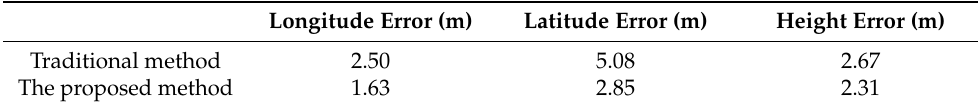
Table 1. Root Mean Square of position error under vehicle stationary condition.